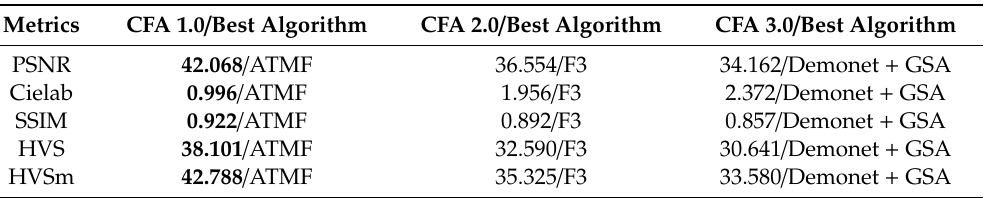
Table 1. Comparison of CFAs for different demosaicing method in the noiseless case (normal lighting conditions). Bold numbers indicate the best performing methods in each row.